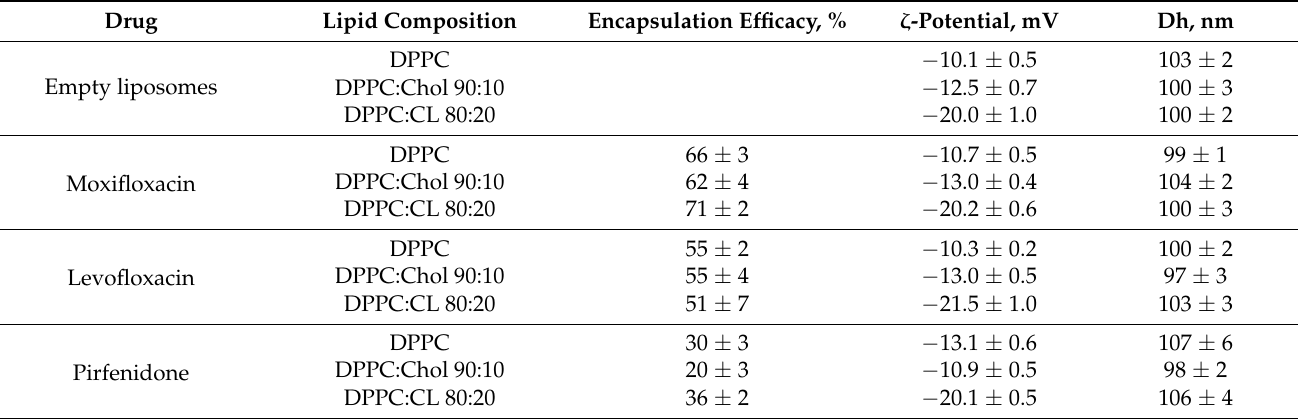
Table 1. Encapsulation efficacy, ζ -potential and hydrodynamic diameter of liposomal form of moxi- floxacin, levofloxacin and pirfenidone of various lipid compositions; 0.02 M Na phosphate-buffered solution, pH 7.4, 22 ◦